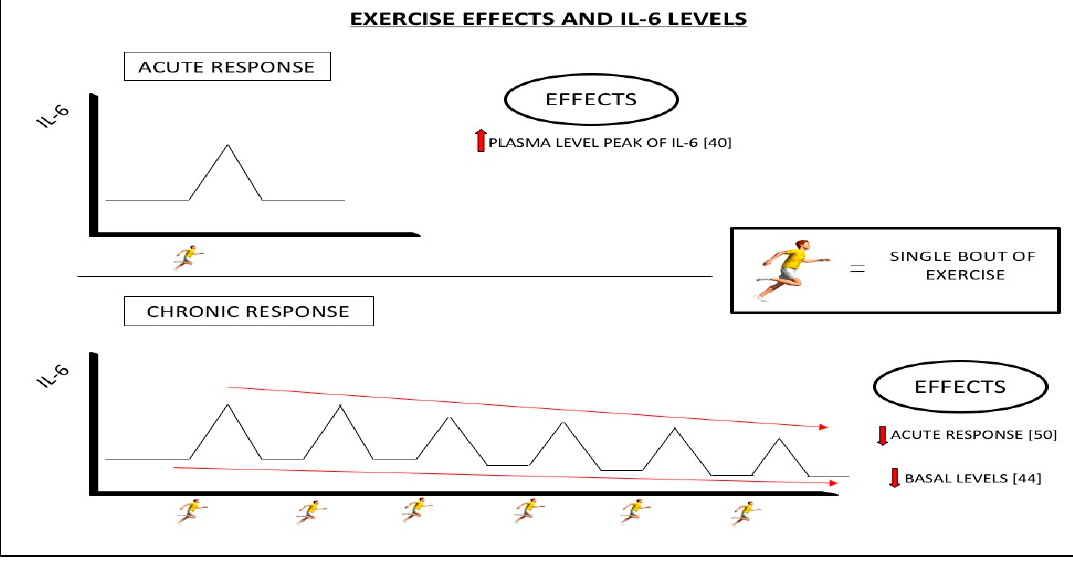
Figure 3. A single bout of exercise causes an increase in plasma levels of IL-6 (ACUTE RESPONSE). However, the regular practice of exercise reduces the acute response to exercise and decreases the basal levels of IL-6 (CHRONIC RESPONSE).